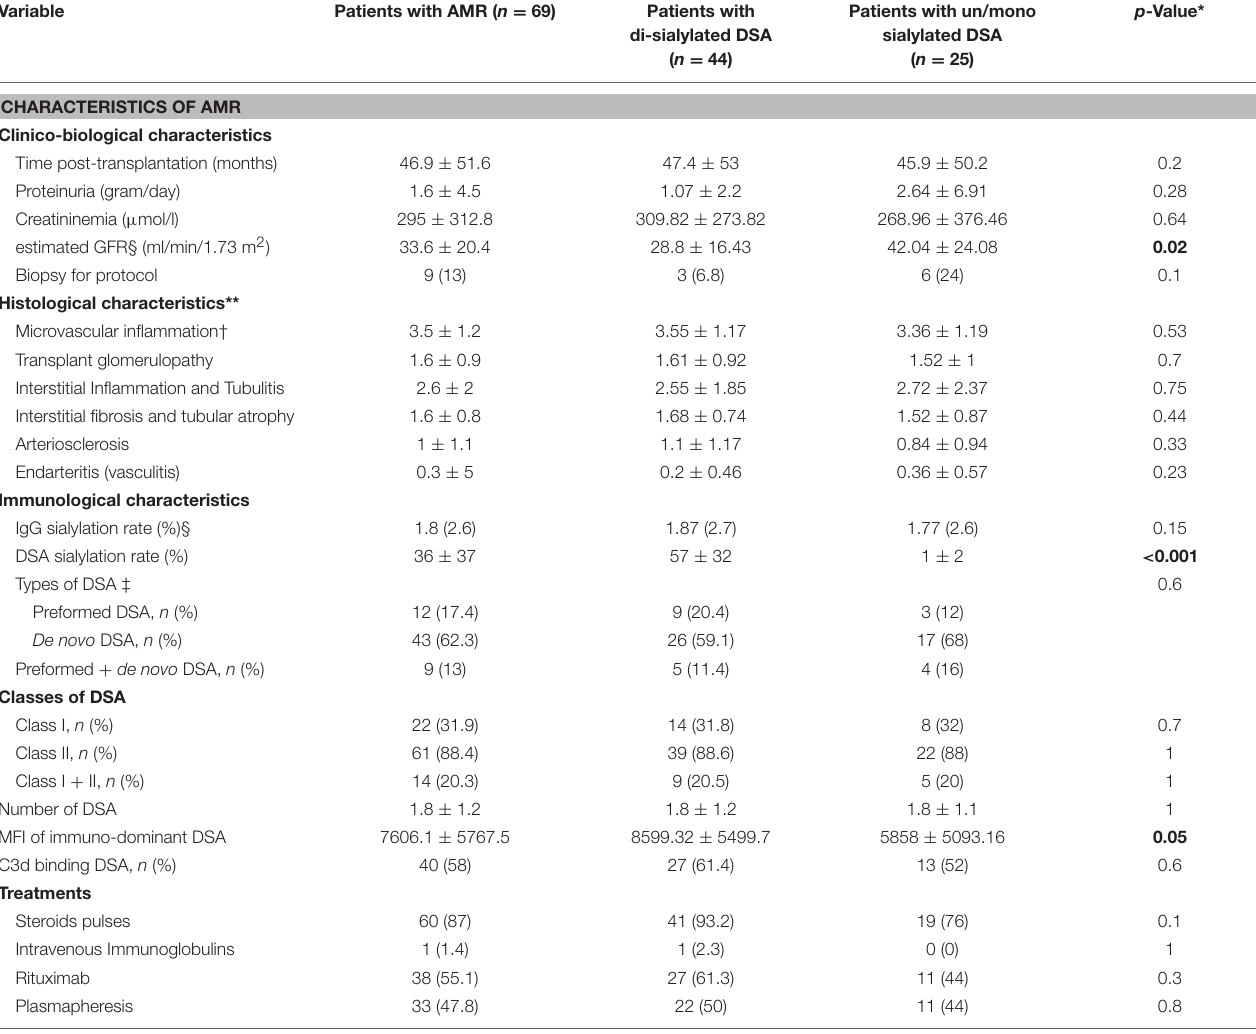
TABLE 2 | Patient characteristics at the time of AMR